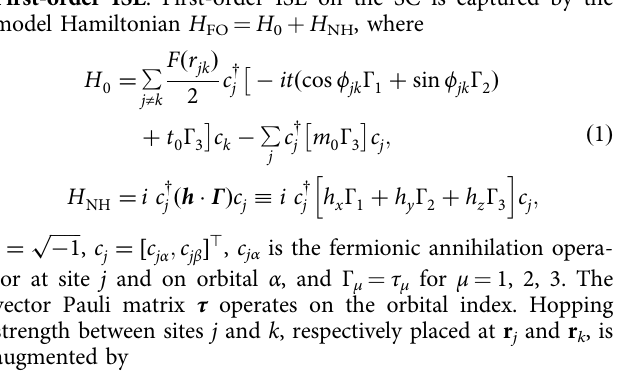
effect on the outer left edge for h = ( h x , 0, 0) [Fig. 1(a)]. With PBC in the x direction or both x and y directions, there is no skin effect anywhere in the system [Fig. 1(b)]. When h = (0, h y , 0), the